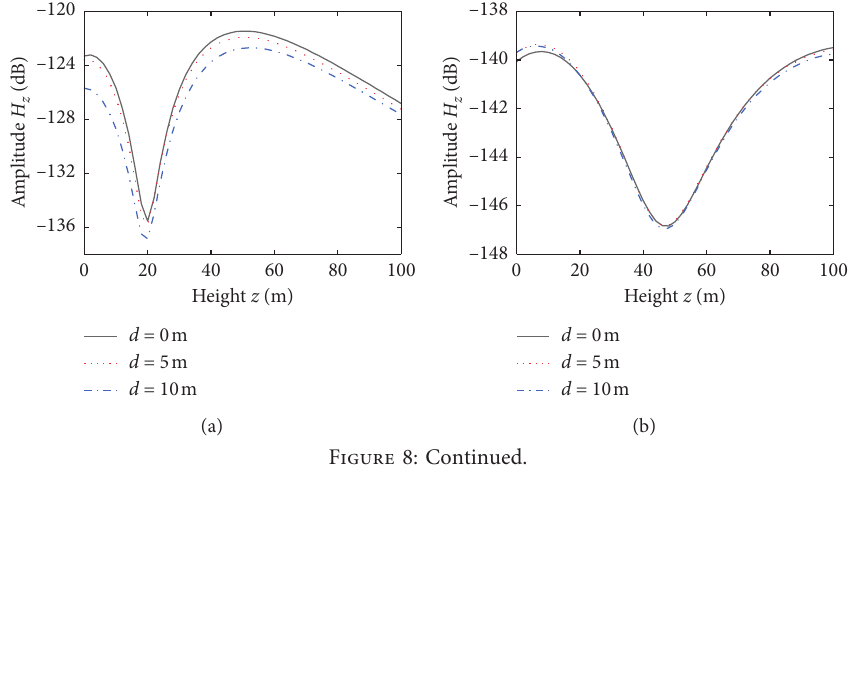
Figure 7: Amplitudes and phase angles of field component H solutions. (a, c) f � 3Hz. (b, d) f � 300Hz.